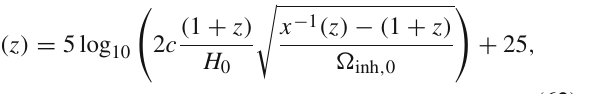
Fig. 3 The apparent magnitude μ with respect to the redshift z , with various of values (cid:17) inh , 0 . The top curve (red) corresponds to (cid:17) inh , 0 = 0 . 9998, the middle curve (black) corresponds to (cid:17) = 0 . 7200, and the bottom inh , 0 curve (green) corresponds to (cid:17) = 0 . 0041. Since (cid:17) inh , 0 inh , 0 can only take values between 0 and 1, this means the model cannot fit observational